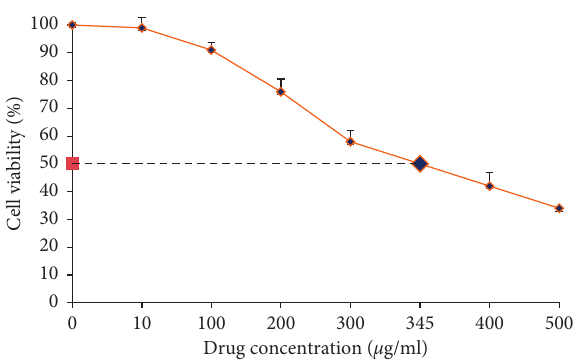
Figure 1: Viability of CEF cells (%) treated with different con- centrations of polyphenon-60 for 48 h p.i. The dot line represented 50% cell viability. Data were expressed as the mean ± SD of three independent